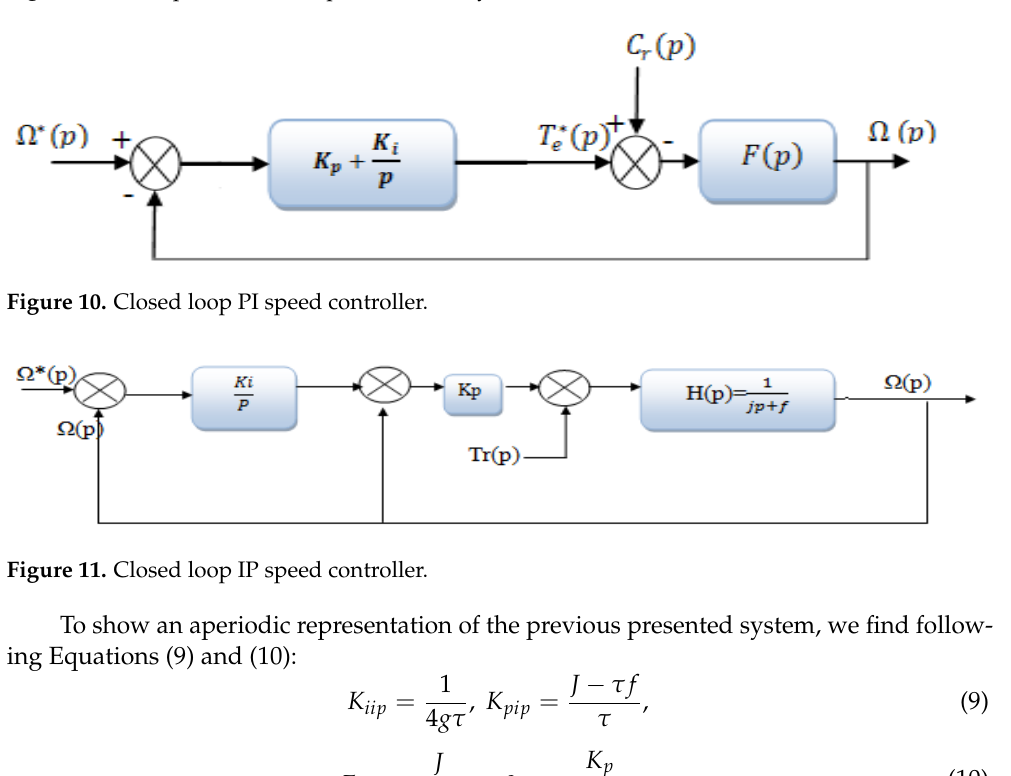
Figure 9. Rotor speed closed loop 3L_FOC IM system.